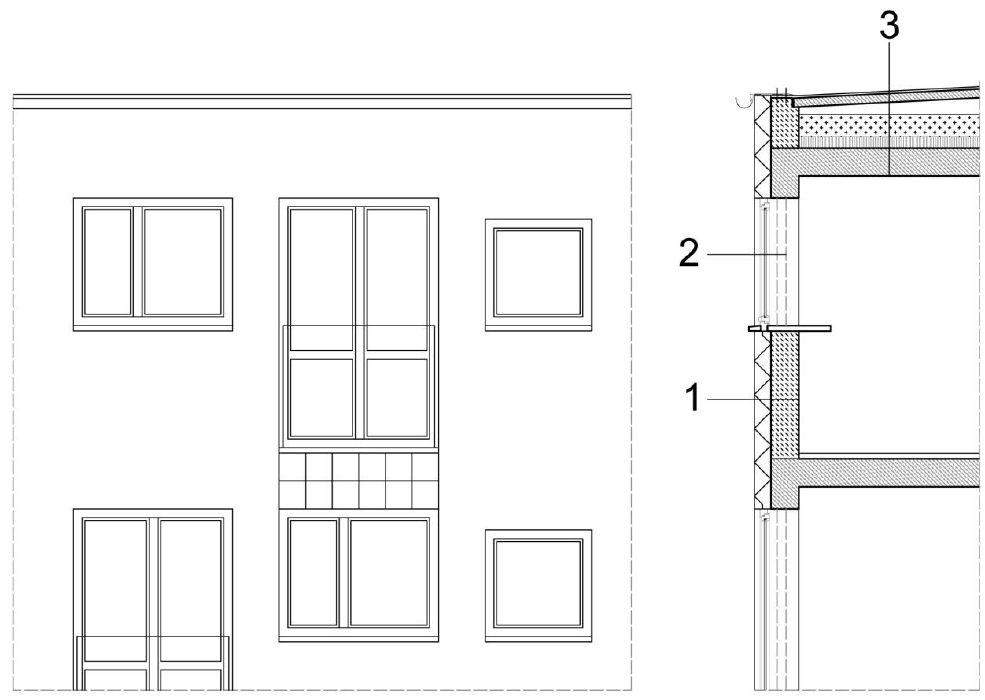
Figure 2. The blocks by Nankiera square—elevation and section. 1. The designed external wall: silicone plaster 1.5 cm, EPS polystyrene 15.0 cm, aerated concrete blocks 24.0 cm, internal plaster 1.5 cm. 2. The depth of the window fixing changed with insulation to preserve the original ratio. 3. The designed roof slab: 2 × roofing felt, levelling layer 2.0 cm, slag concrete slabs in decline 8.0 cm, ventilation gap 10.0, the blow of mineral wool granules 20.0 cm, prefabricated channel slabs 24.0 cm, internal plaster 1.5 cm (drawn by the Authors).